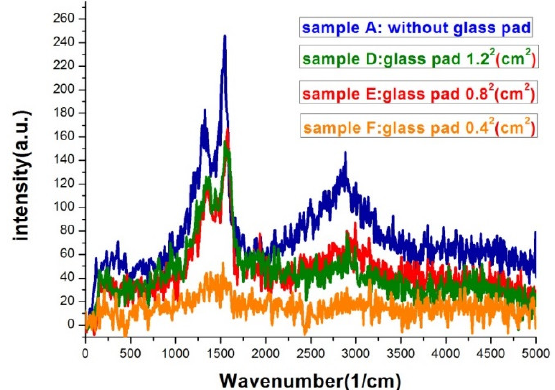
Figure 8. Raman spectra of silver island films with glass pads underneath during thermal evaporation.